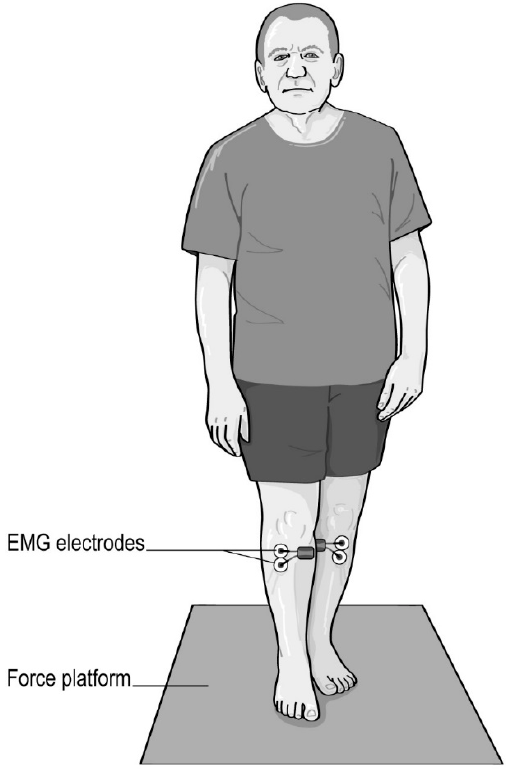
Figure 1. Semi-tandem stance with eyes opened.